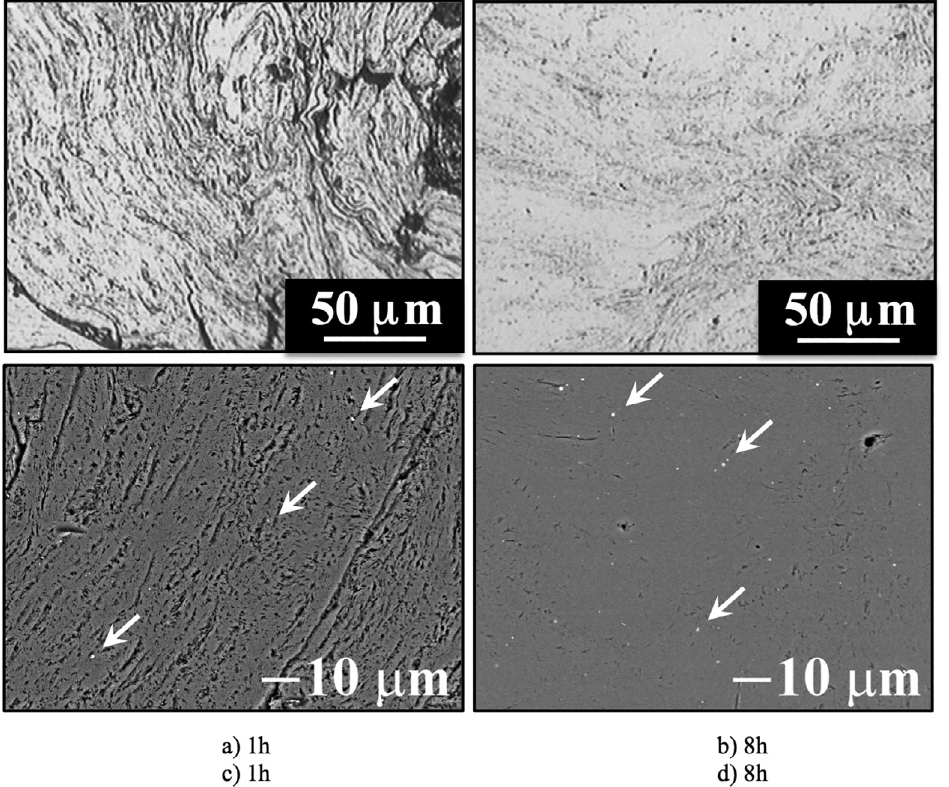
Figure 2. Cross section optical images of Al milled samples a) 1h and b) 8h. SEM-BSE micrographs of Al-1.0%MG composites milled c) 1h and d) 8h, white bright dots are the MG particles embedded in the metal